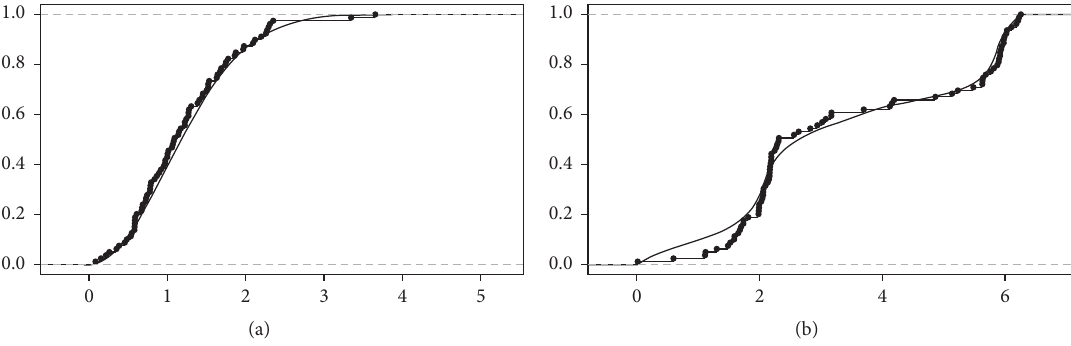
Figure 10: Simulated empirical cdf of the marginal distributions of 𝑅 (a) and Φ (b) of the second group of data and Φ 𝑔, P 𝐿𝑇 ,̂𝑉𝜗+̂𝜌,̂𝑉Ψ̂𝑉 𝑇 .